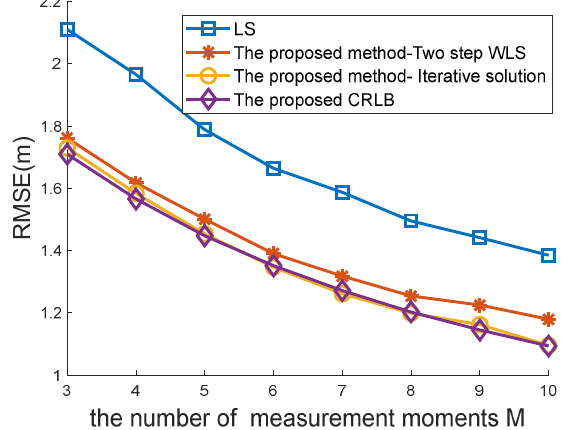
Figure 7. Comparison of the proposed methods under different